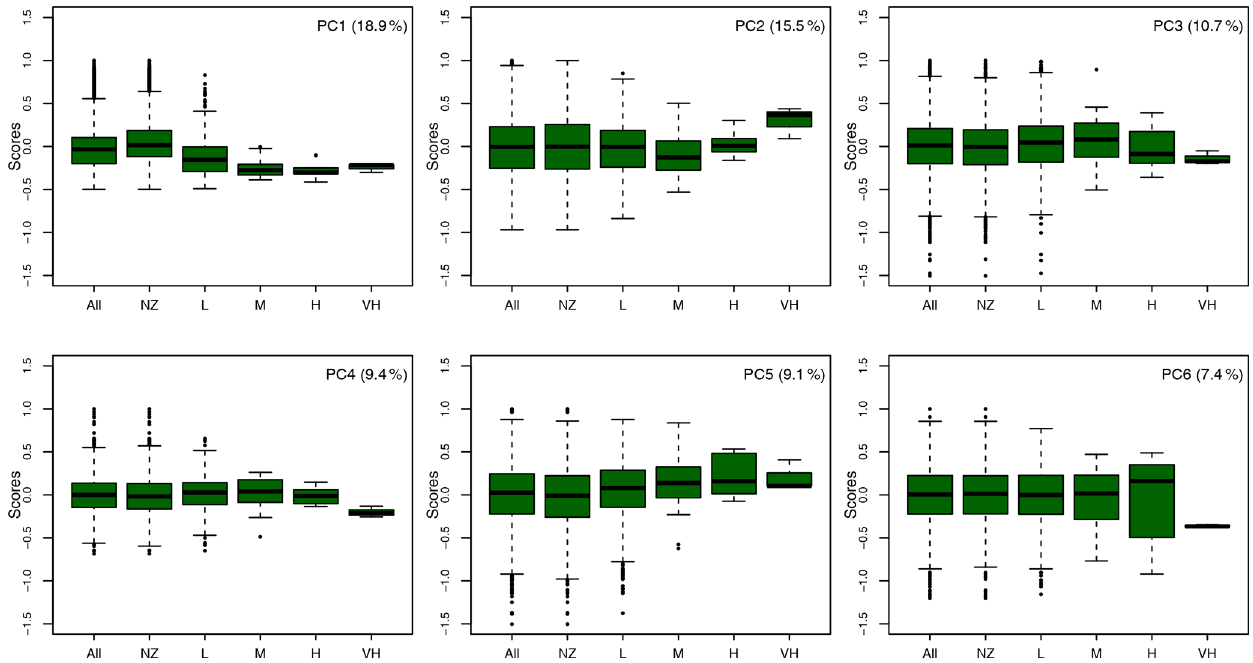
Figure 5. Boxplots showing the distribution of PC weights according to the recurrence categories. All represents the distribution of each PC throughout the whole study area.